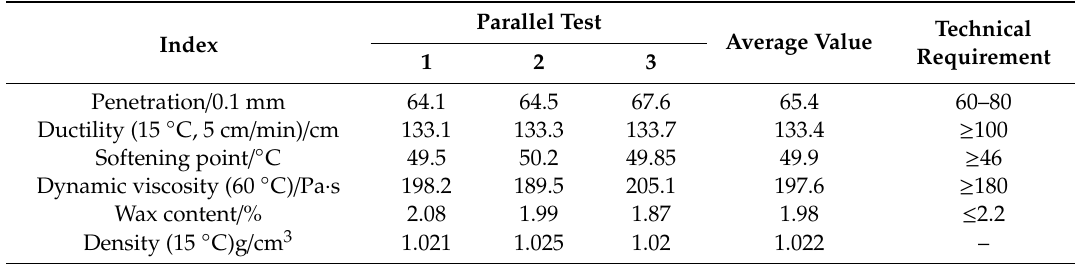
Table 1. Indices of neat asphalt.